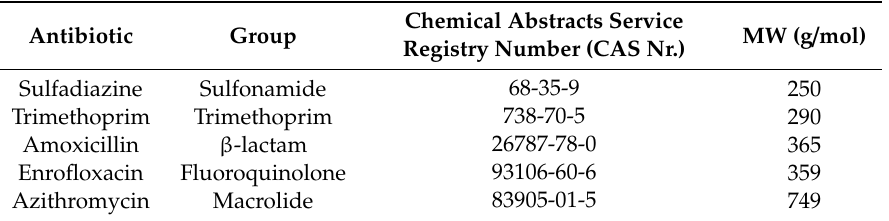
Table 3. Selected antibiotics and chemical